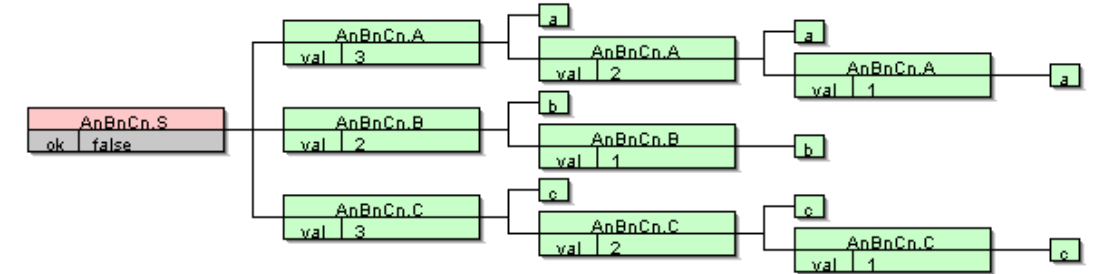
Figure 2. Computation of attributes for sentence “aaabbccc”.